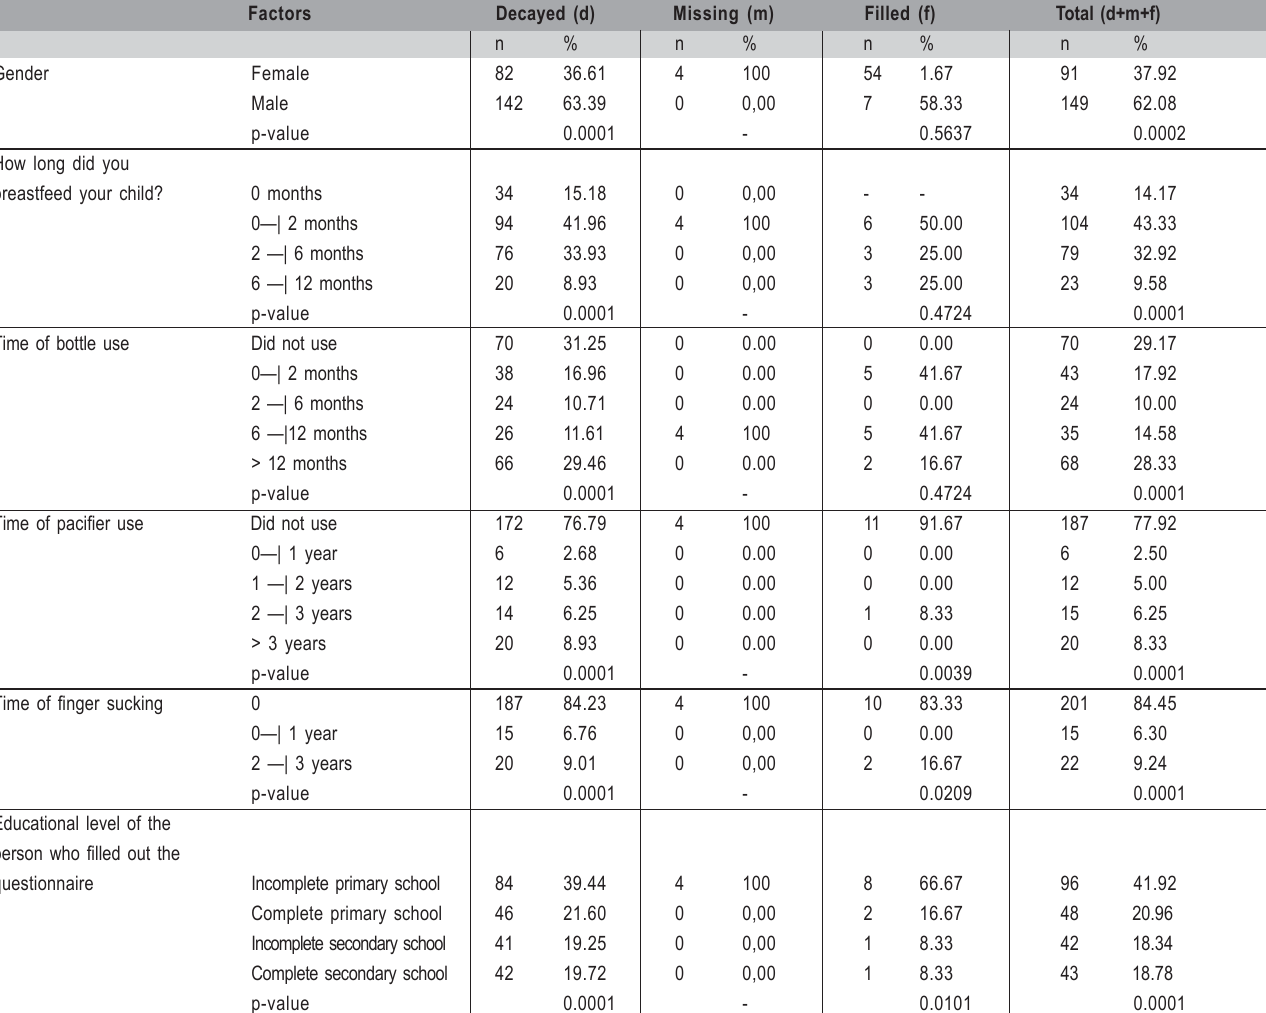
Table 3. Frequency and percentage of occurrence of decayed, missing and filled teeth (dmft) in different strata defined for the survey.